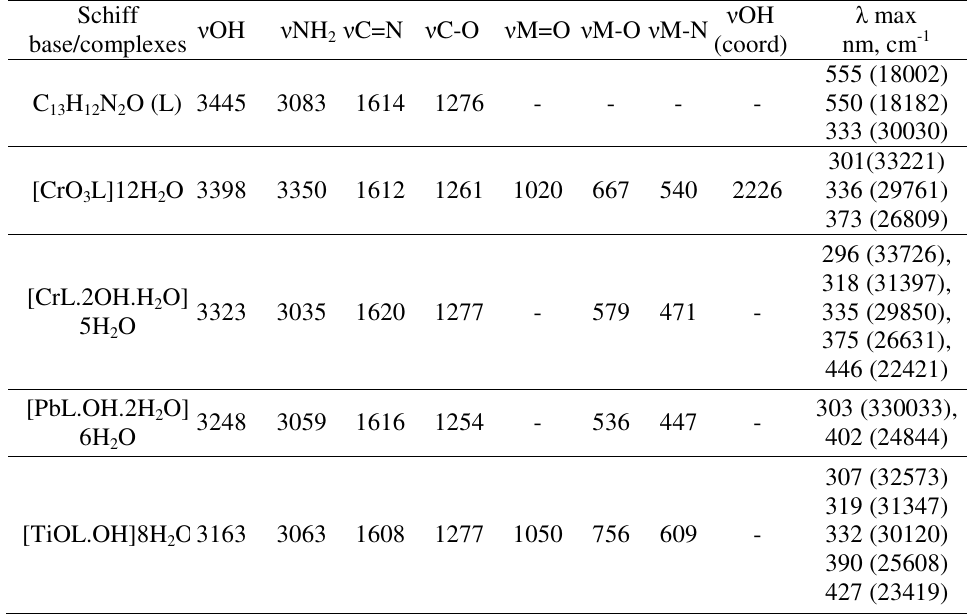
Table 3. Infrared spectral data of the Schiff base and its complexes Schiff